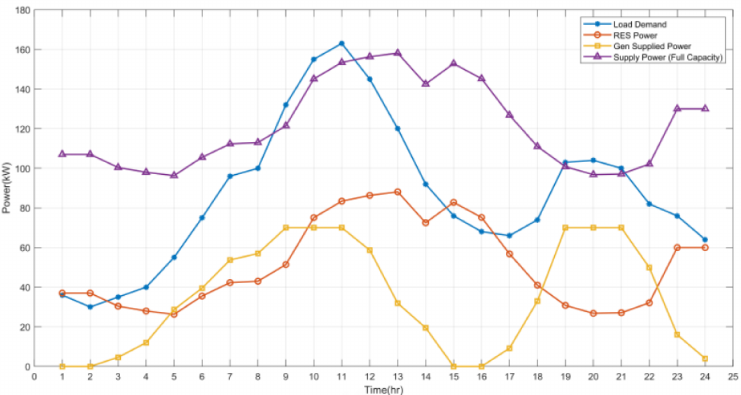
Figure 5. Power dispatch by the microgrid in Scenario